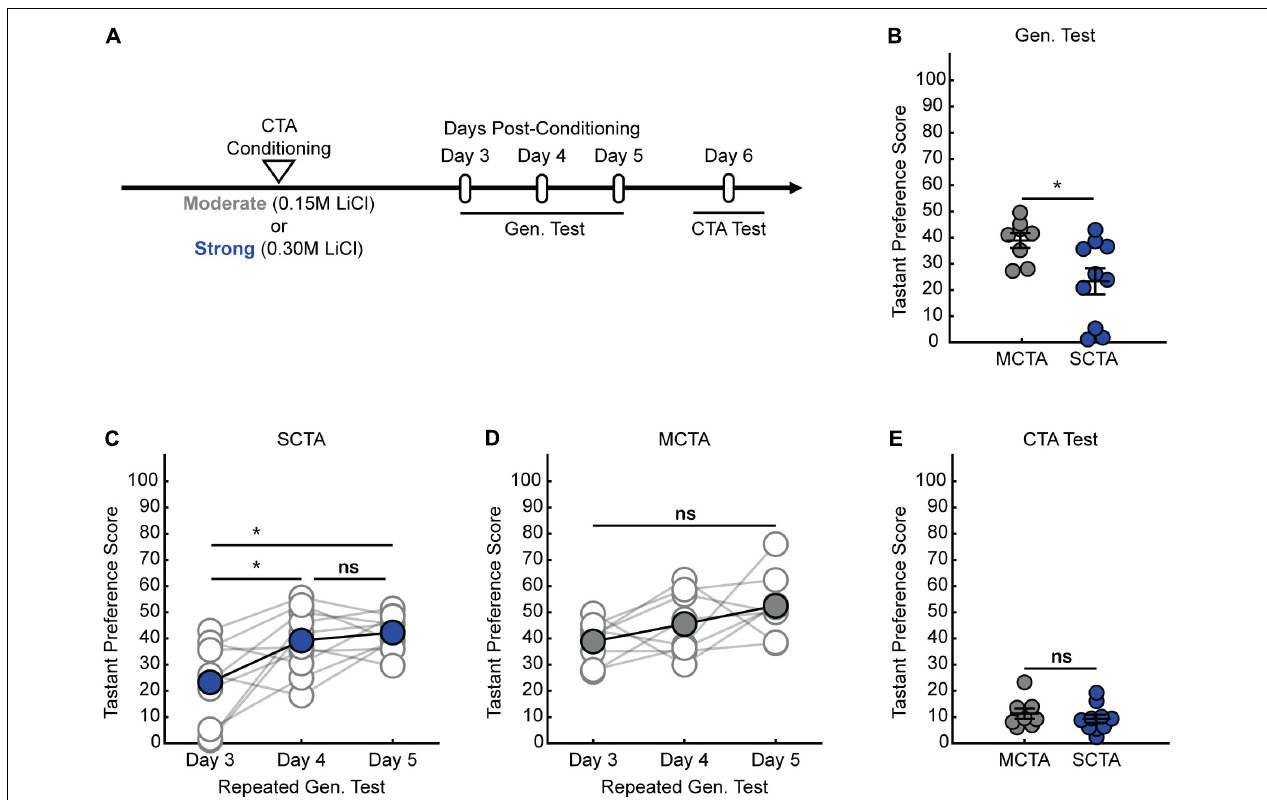
FIGURE 1 | Strong aversive conditioning triggers a long-lasting generalized aversion. (A) Two-bottle CTA learning paradigm for testing the persistence of the generalized aversion. (B) Gen. test; preference score for salt tested 3 days post-conditioning (two-sample t test, p = 0.0220). (C) SCTA repeated Gen. test; preference for salt tested at 3-, 4-, and 5-days post-conditioning (One-way ANOVA, p = 0.0036; Tukey-Kramer post hoc tests, day 3 vs. day 4, p = 0.0184; day 3 vs. day 5, p = 0.0047; day 4 vs. day 5, p = 0.8430). (D) MCTA repeated Gen. test; preference for salt tested at 3-, 4-, and 5-days post-conditioning (One-way ANOVA, p = 0.0716). (E) CTA test; preference score for saccharin of 3-day experimental conditions (two-sample t test, p =